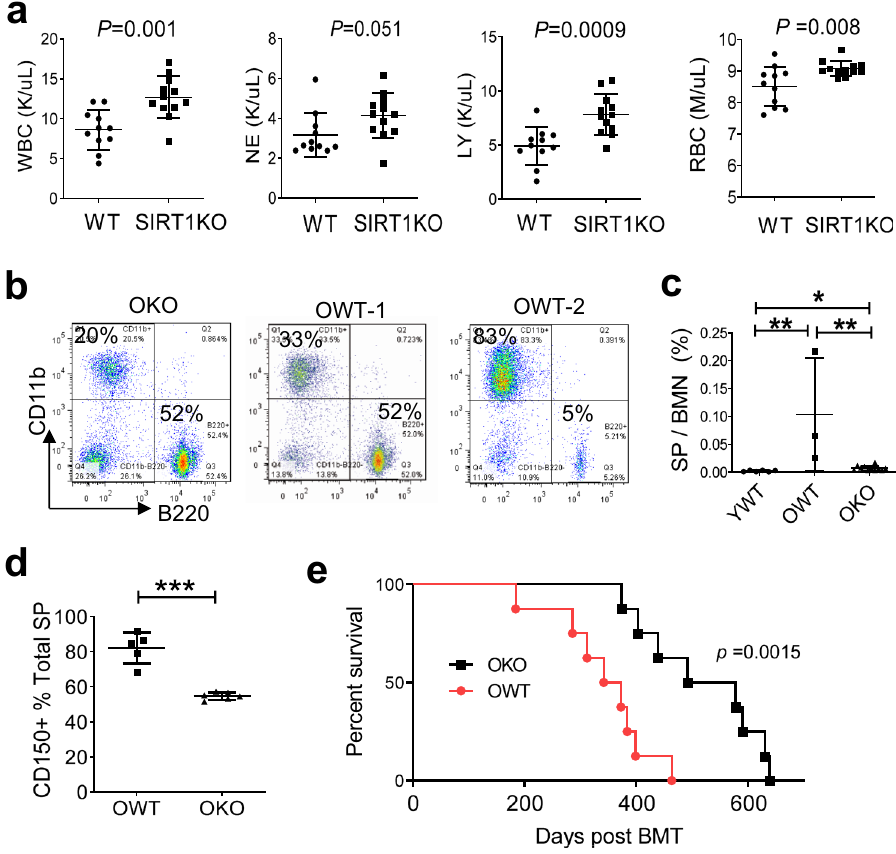
Fig. 2 SIRT1 knockout inhibited the skewed differentiation of old HSCs in the 1st BMT recipients and improved mouse survival. a Differential blood cell counts in 1st BMT recipients 8 months after transplantation with 14-month donor marrow (14-8 series). b – d Analysis of another BMT series 10 months after transplantation with 20-month-old donor marrow (20-10 series) to 8-week-old YWT recipients. b peripheral blood B220 + vs. CD11b + cells; c bone marrow SP cell analysis; d CD150 fraction of bone marrow SP cells. CD150 is a marker for long-term HSCs. CD150 + SP cells are known to increase with aging, but they were markedly reduced by Sirt1 knockout in the 1st round BMT recipients. e Kaplan – Meier survival analysis of 1st round OKO and OWT BMT recipients in another 20-X series in 5-month-old recipients. * P < 0.05; ** P < 0.01; *** P < 0.001. Error bars represented one standard